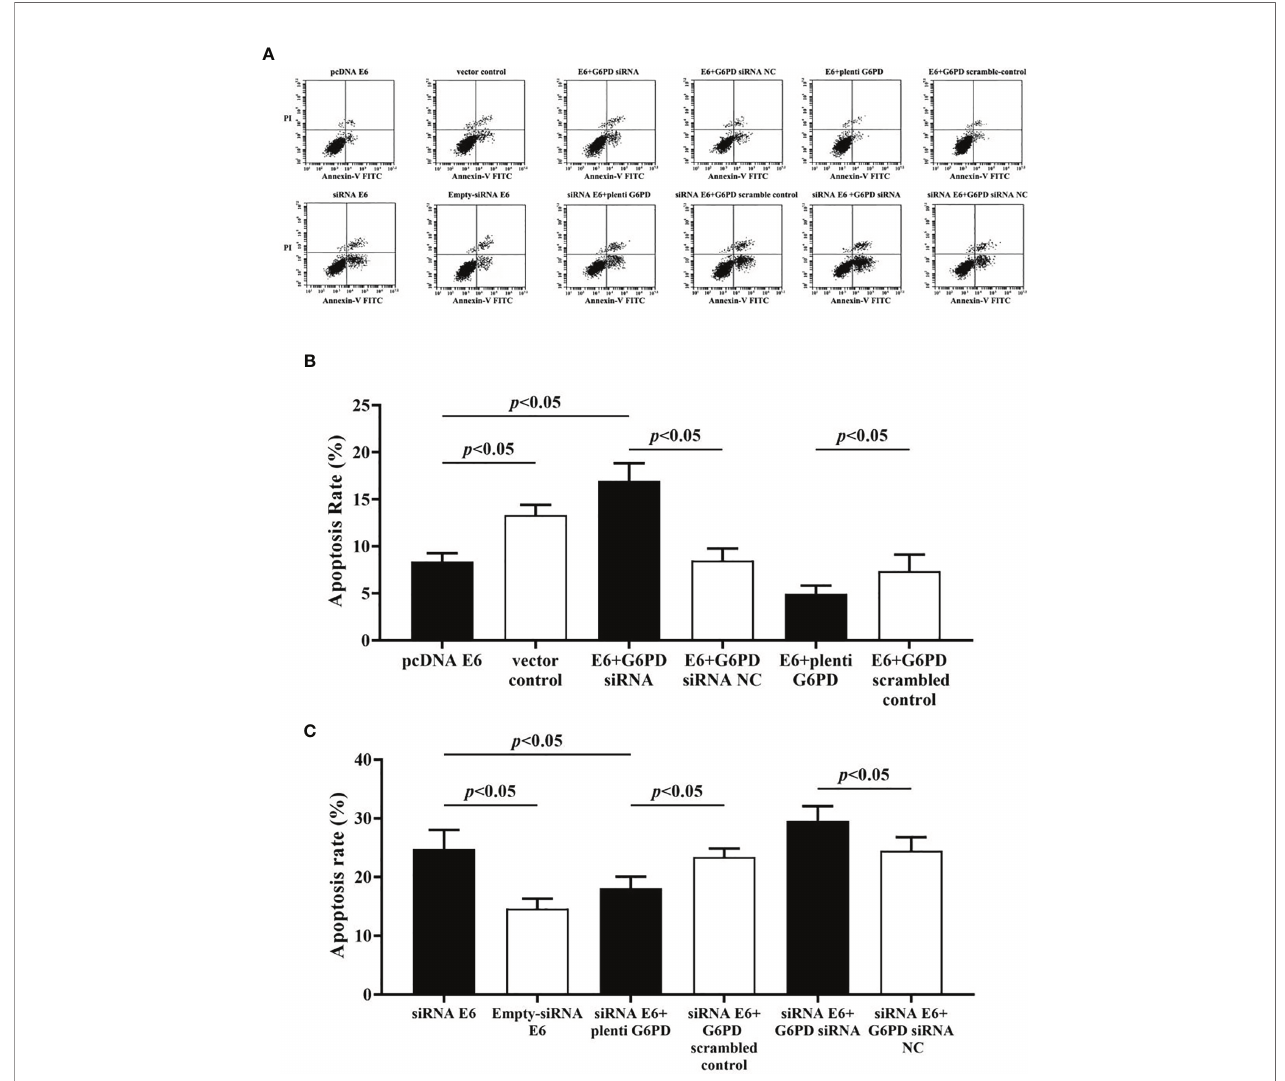
FIGURE 8 | Apoptosis rate of HeLa cells with various treatments were evaluated by the fl ow cytometry (FCM) assay. (A) Representative apoptosis records indicated by Annexin-V FITC-PI assay derived from HeLa cells accepted different treatments. (B, C) Statistical plots in apoptosis rates of HeLa cells with different treatments. Data are presented as means ± SD ( n =